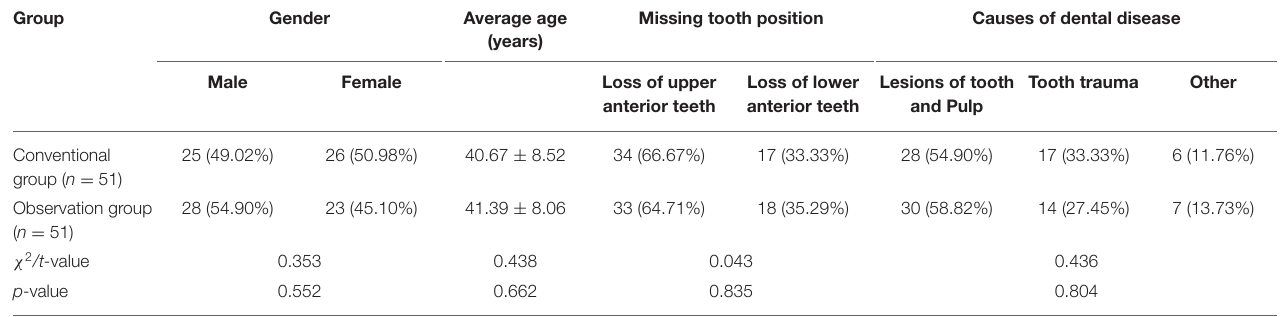
TABLE 1 | Comparison of general data between the two groups (n, %, ¯ x ± s). Group